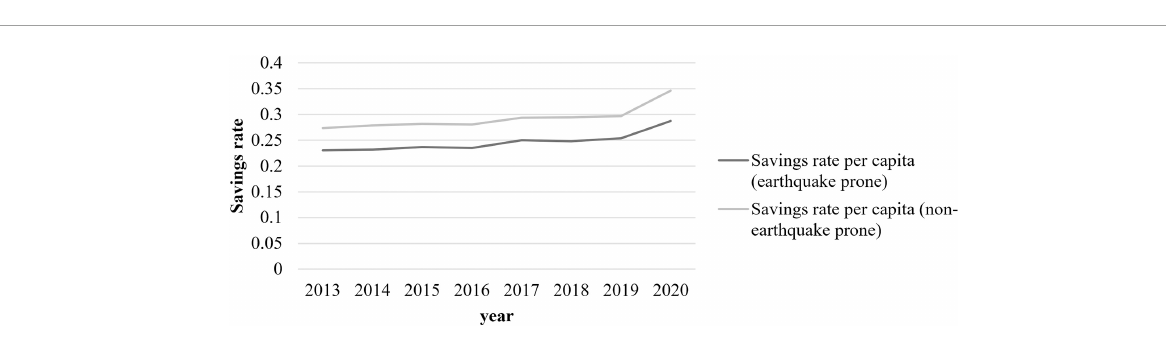
FIGURE2 Comparison of per capita savings rate between earthquake-prone regions and non-earthquake-prone regions [The per capita savings rate is calculated using (per capita disposable income of residents − per capita consumption expenditure of residents)/per capita disposable income of residents in each province].